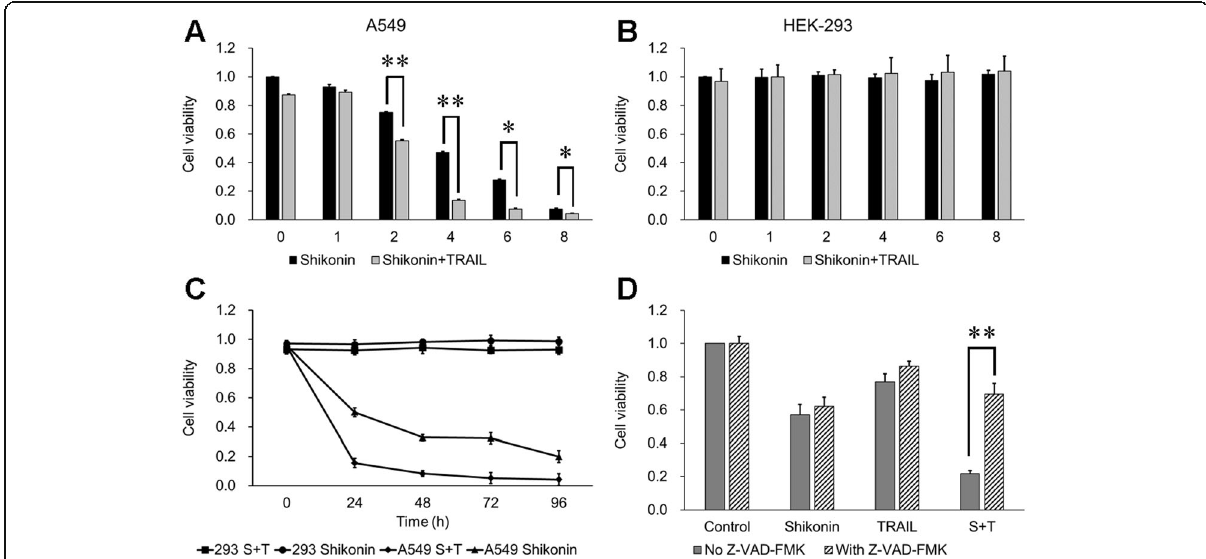
Fig. 1 Effect of shikonin on TRAIL-induced cell cytotoxicity. The viability of ( a ) A549 and ( b ) HEK-293 cells after treatment were determined by a CCK8 assay. Cells were pretreated with different concentrations of shikonin for 12 h and then further incubated in the presence or absence of TRAIL (50 ng/ml) for another 12 h. c In the long-term cytotoxicity experiment, HEK-293 cell viability was not influenced by shikonin and TRAIL over the 96 h incubation period; however, the viability of A549 cells was significantly inhibited by shikonin, especially with TRAIL cotreatment. d These data show the efficacy of shikonin (4 μ M) and TRAIL (50 ng/ml) on A549 cells pretreated with Z-VAD-FMK (50 μ M). The data are presented as the means ± SDs of at least three independent experiments, * p < 0.05 and ** p < 0.01. S + T: Shikonin +